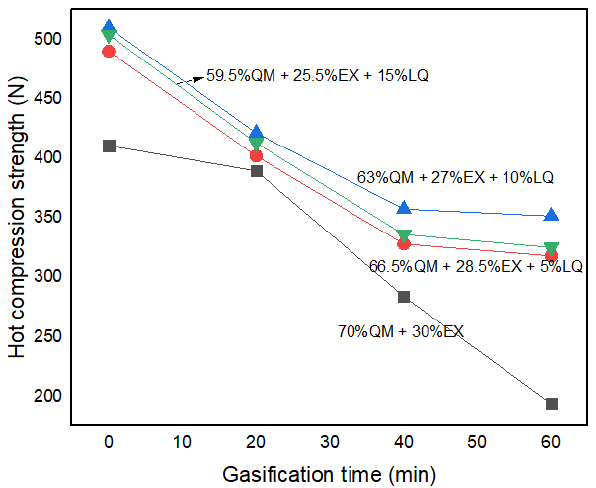
Figure 18. Hot compressing strength of samples during